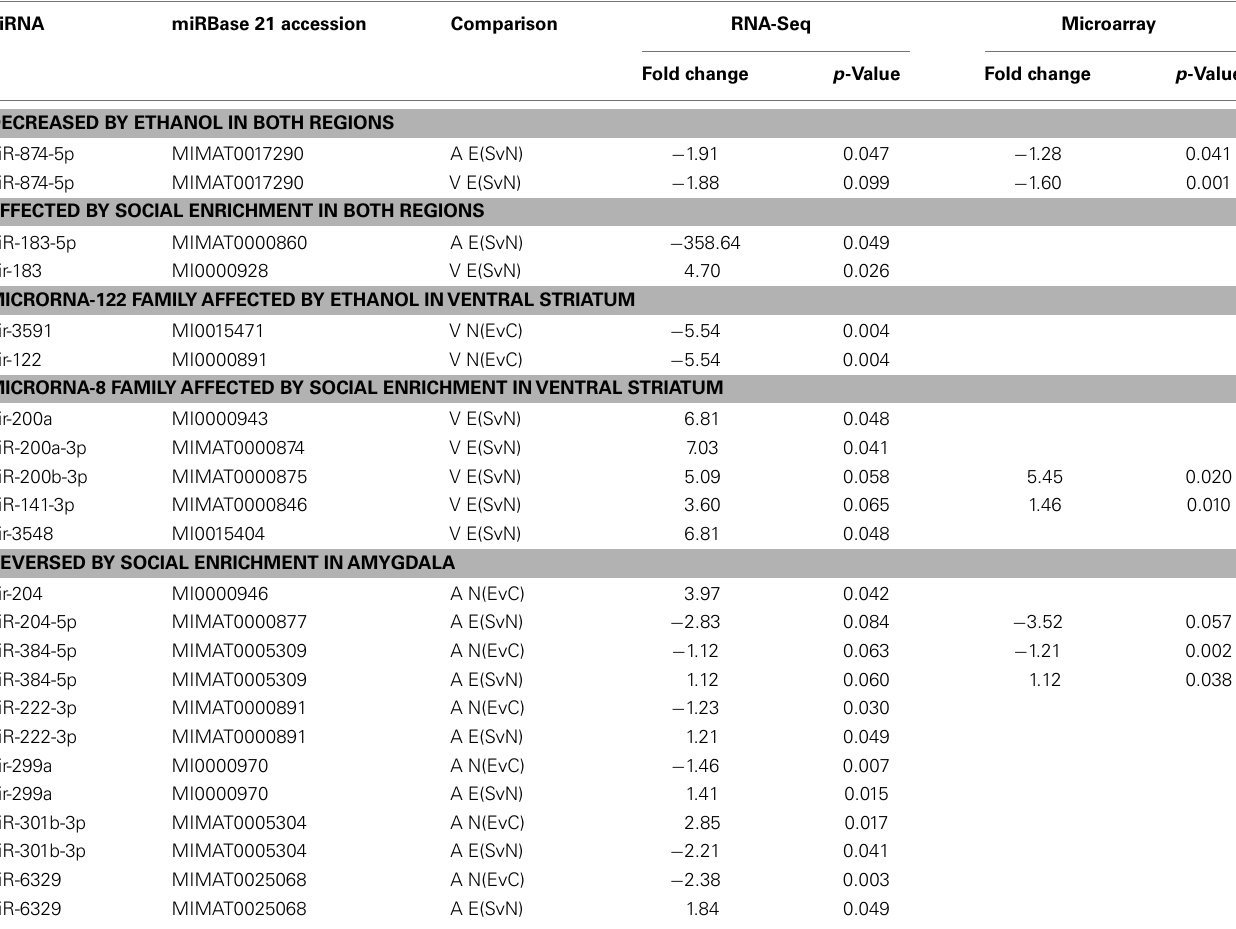
Table 3 | Notable miRNA comparisons